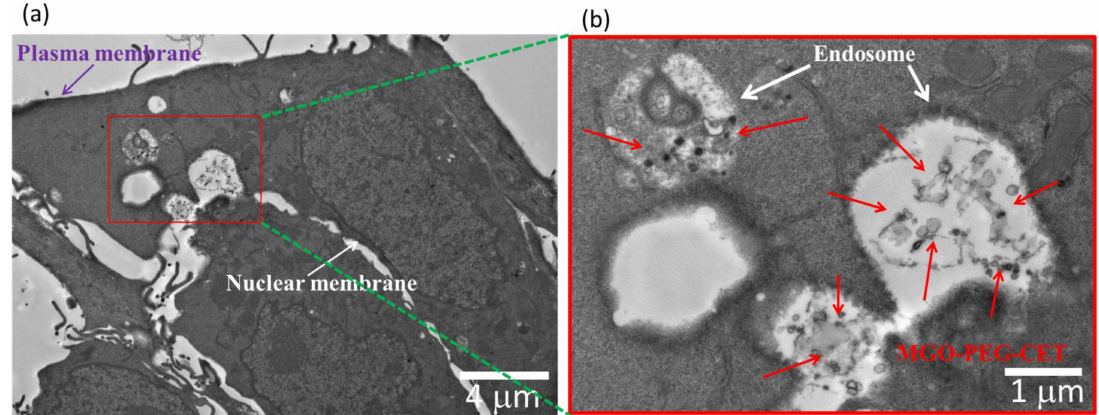
Figure 6. The transmission electron microscope (TEM) micrographs of CT-26 cells after contacting with MGO-PEG-CET for 1 h, bar = 4 µ m. ( b ) is the magnified image of the red square shown in ( a ), bar = 1 µ